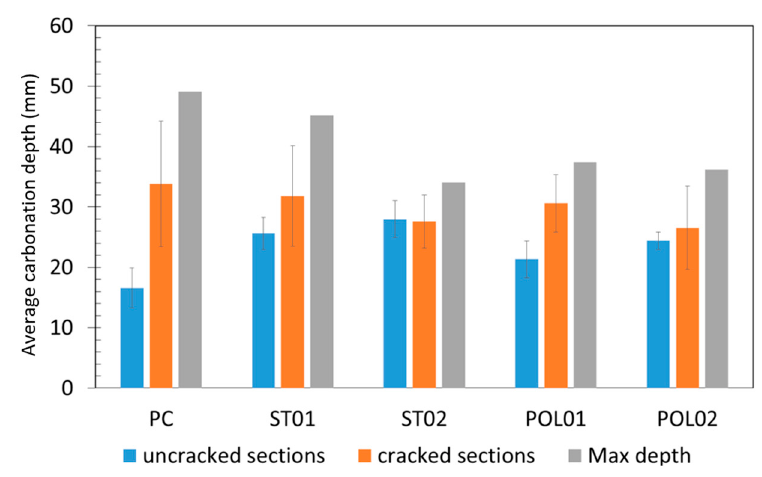
Figure 7. Carbonation depth and standard deviation for 72-month exposed beams.